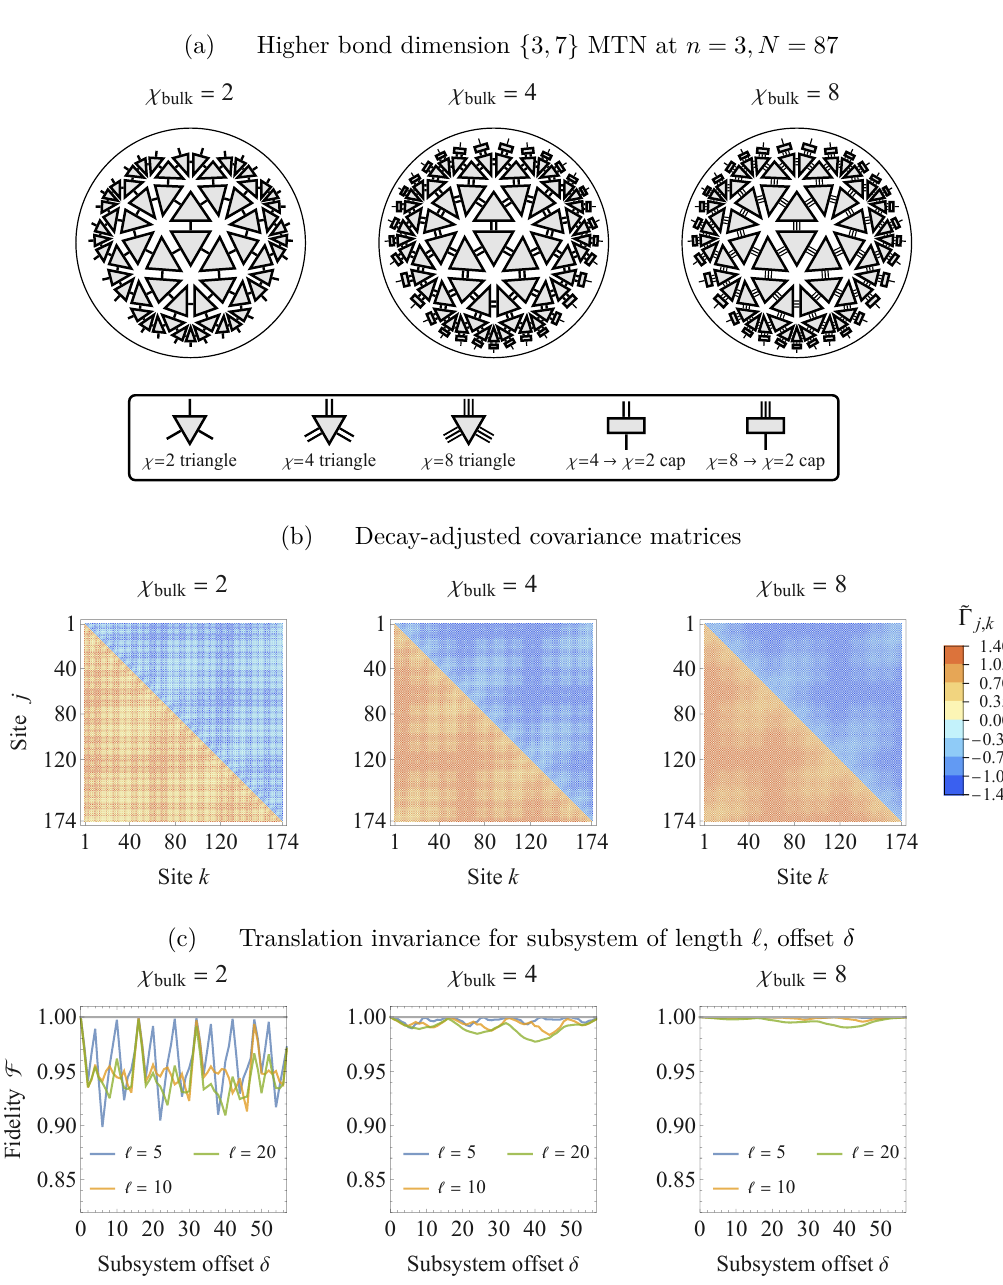
Figure 12 . Construction of matchgate tensor networks (MTN) with higher bond dimension χ bulk . (a) Tensor network construction on a { 3 , 7 } tiling with χ bulk = 2 , 4 , 8 , represented by log fermionic bonds in the matchgate formalism. For χ bulk ≥ 4 , additional cap tensors on the boundary legs reduce the boundary bond dimension to χ bdy = 2 . (b) Decay-adjusted covariance matrix ˜Γ of the MTN boundary states at the critical Ising point (minimum energy with respect to H I ). (c) Fidelity F of subsystems of the disorder vector g extracted from each covariance matrix (via (3.4)) under translations (compare figure 10). At large χ bulk the disorder approaches the translation- invariant case F = 1